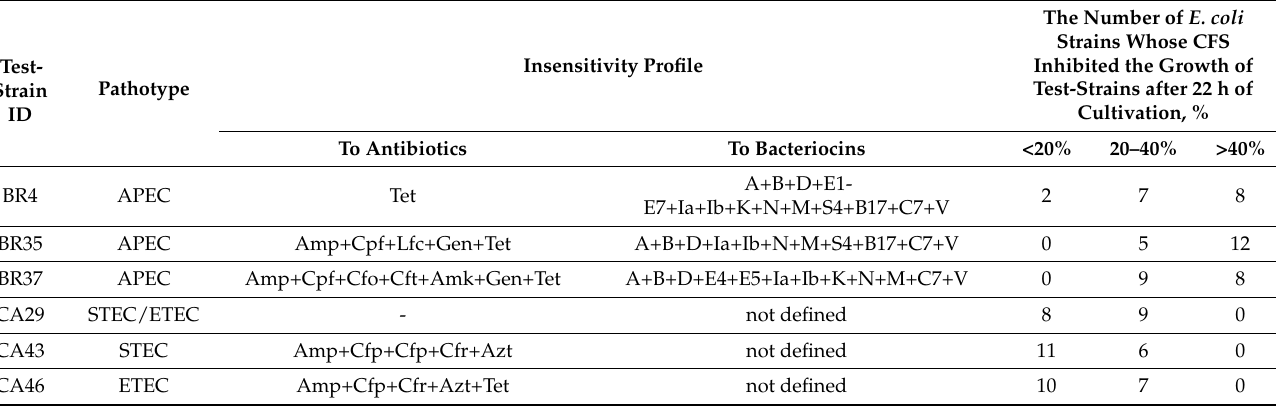
Table 5. Characteristics of the tested APEC in IPEC strains in relation to the inhibition efficiency CFS of bacteriocin-producing E. coli strains.